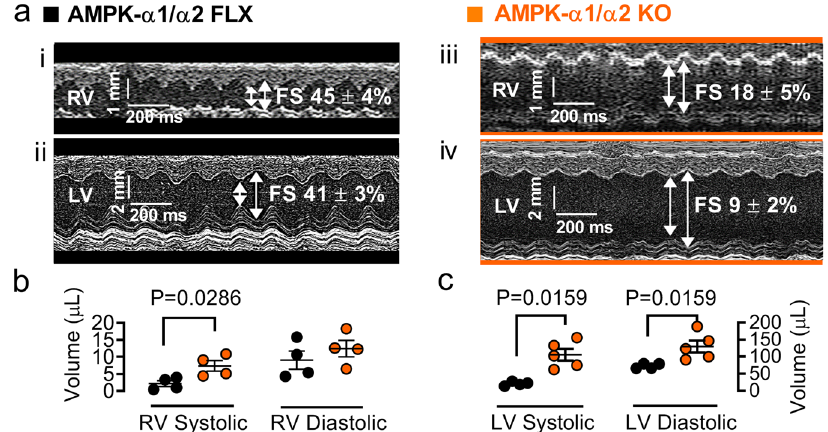
α 1/ α 2 fl oxed controls (AMPK- α 1/ α 2 FLX, n =4 mice) and AMPK- α 1/ α 2 knockout (AMPK- α 1/ α 2 KO, n =4 mice for RV volumes and n =5 mice for LV volumes). Data are expressed as mean±SEM. Statistical signi fi cance was assessed by two-sided unpaired Mann – Whitney ’ s test.